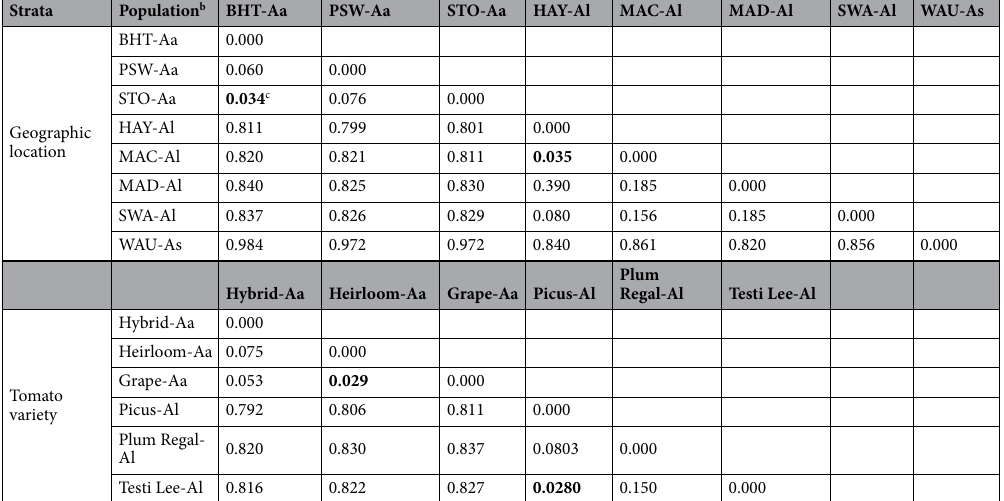
df a Variation (%) SS b MS c Est var. d Fixation indices e P value